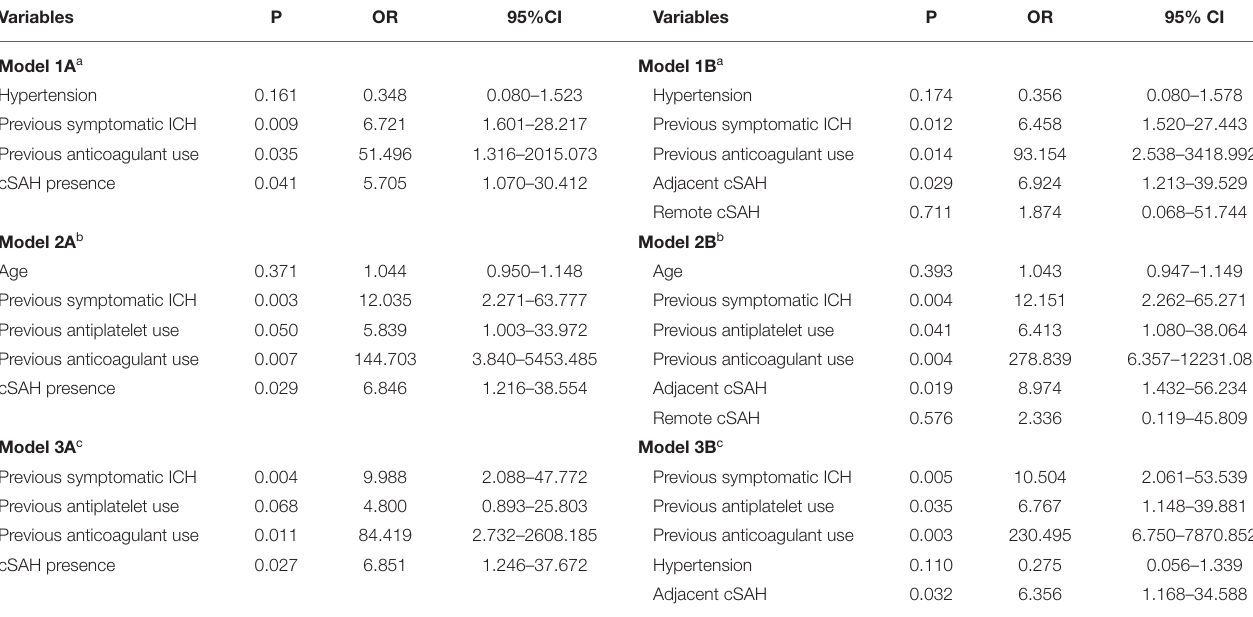
TABLE 3 | Multivariate regression analysis of predictors of ICH recurrence within 2